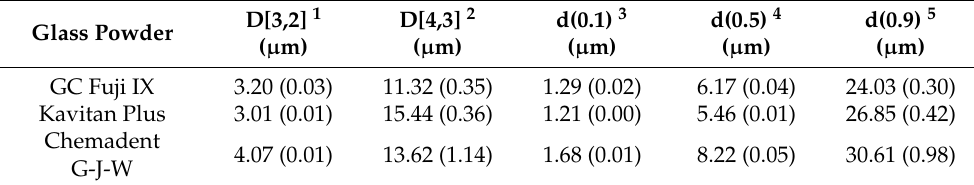
Figure 4. Particle size distributions in the three ionomer glass powders (average of five measurements). Table 2. Particle size data from laser diffraction measurements (standard deviations in